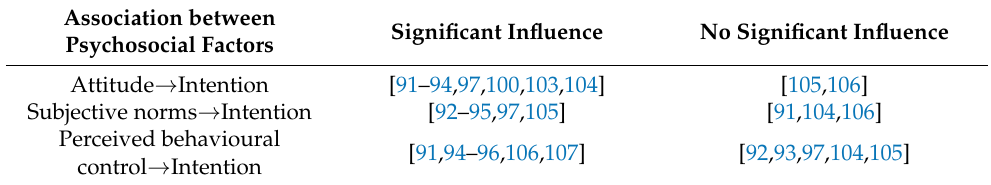
Table 3. Attitude, subjective norms, and perceived behavioural control influence the intention to consume aquatic